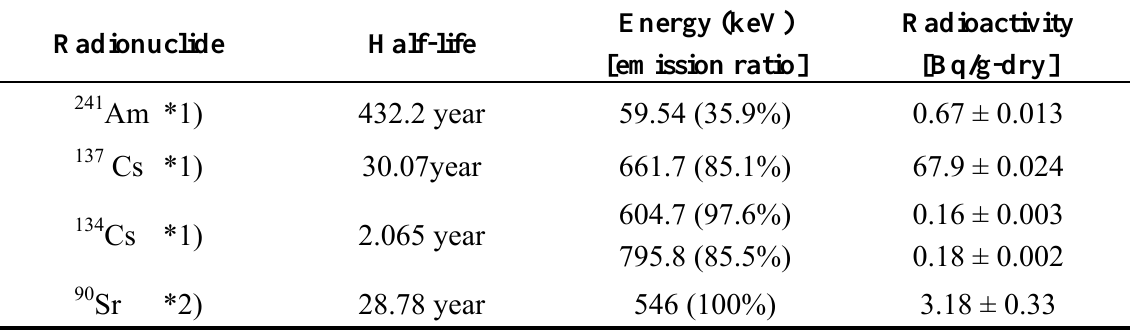
Control Soil -0.49 μ